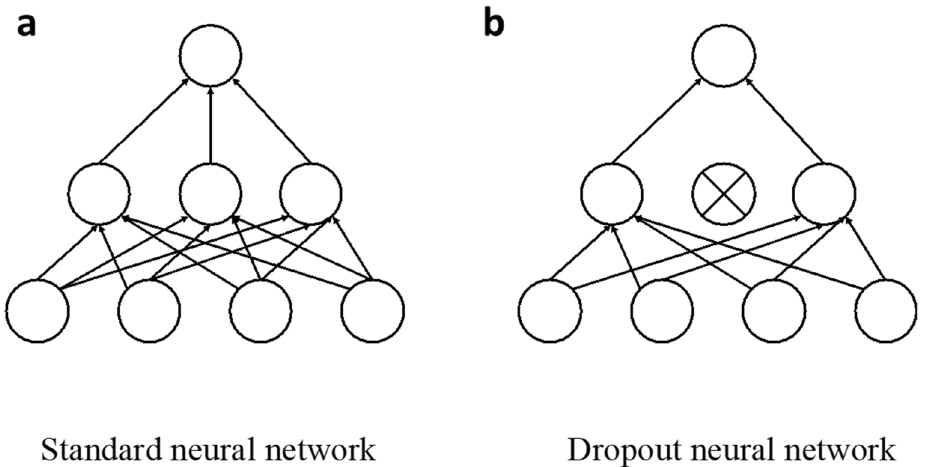
Figure 7. Schematics of a standard neural network (a) and the DONN (b)